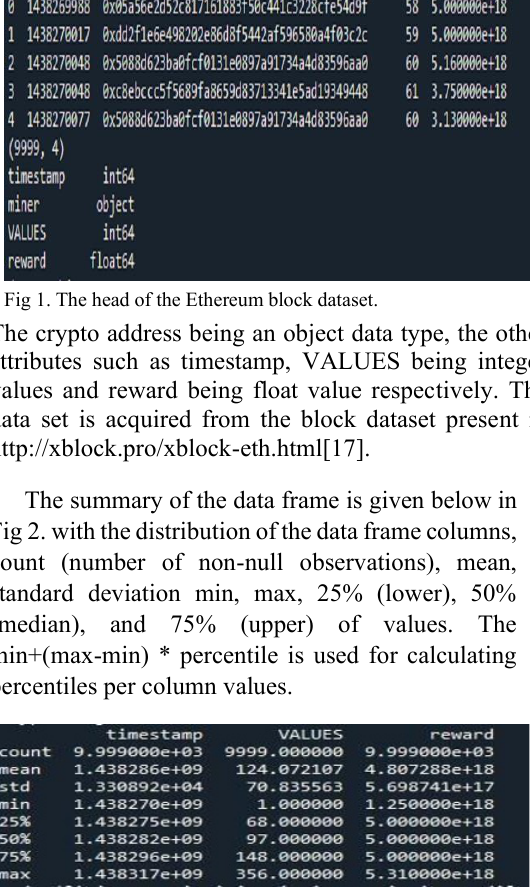
Fig 2. Summary of the block dataset.